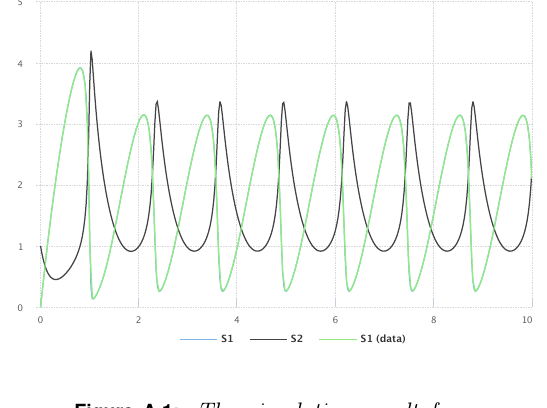
Figure A.1: The simulation result from the simulation description given in List- ing A.2. Simulation with SED-ML web tools [2].